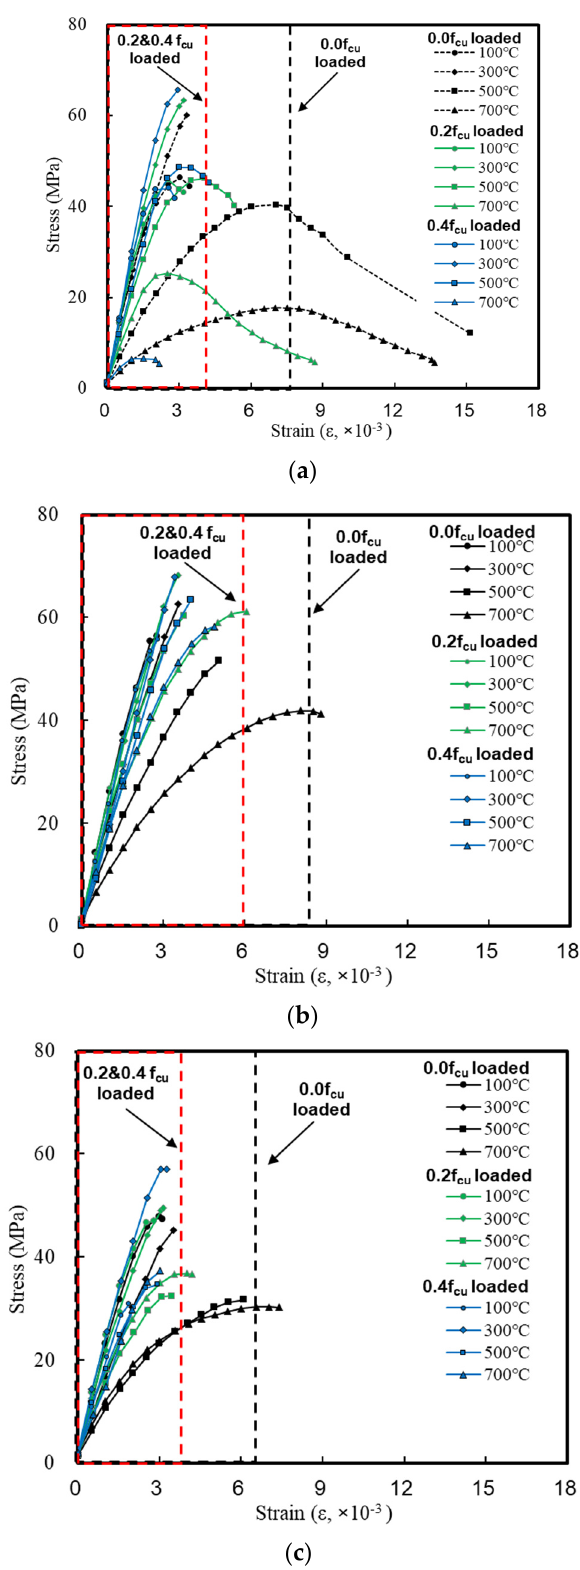
Figure 6. Stress–strain curve of concrete. ( a ) GC. ( b ) AC. ( c ) CC.